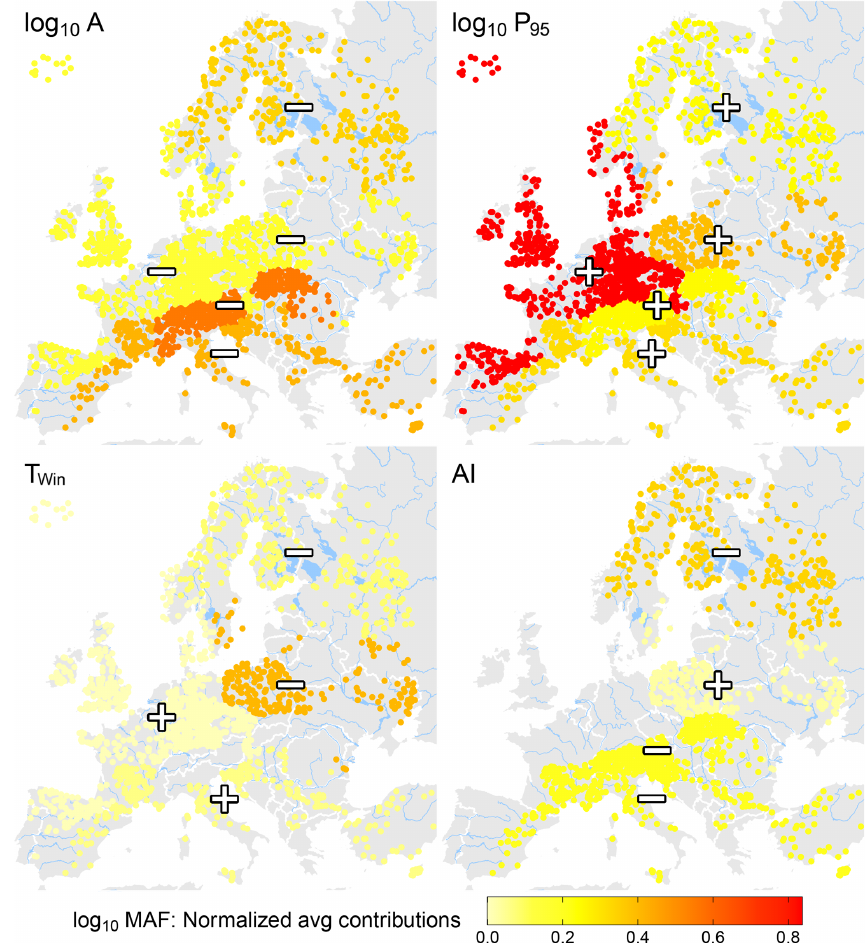
Figure 7. Results of dominance analysis for regional regression models for MAF. Panels depict the average contributions (normalized general dominance measure, nGDM) of the covariates included in the regressions (log of catchment area, log of extreme precipitation index P 95 , mean winter temperature, and AI). Plus and minus signs indicate signs of the regression